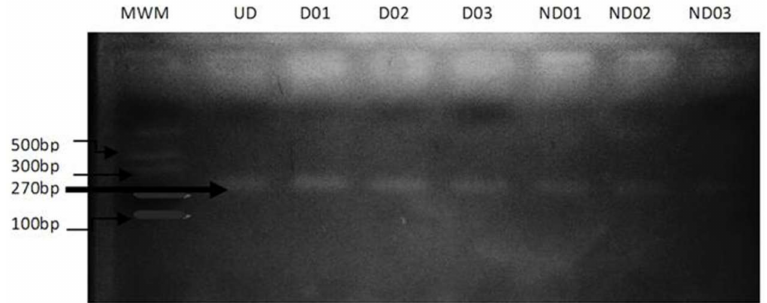
Figure 1. RFLP-PCR of PPAR γ 2 Pro12Ala Polymorphism. Samples were analyzed on a 3% agarose gel after restriction digest. D01–D03 = Samples for diabetic patients; ND01–ND03 = Samples for non-diabetic patients; UD = Undigested sample (control); MWM = Molecular weight